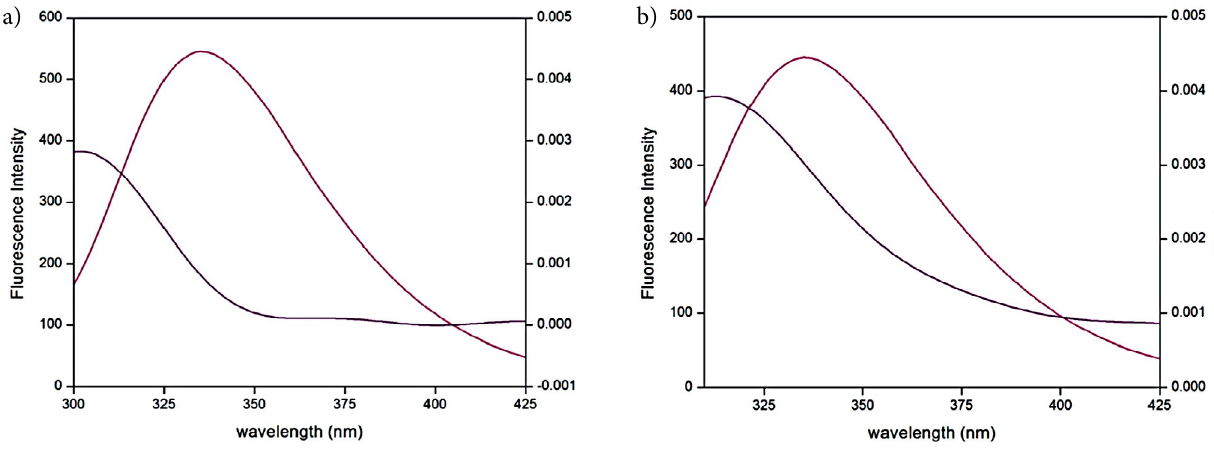
Fig 9: Spectral overlap of UV-Vis absorption spectrum of metal complexes with the fluorescence emission spectrum of BSA. c (BSA) = c (Metal com- plex) = 2 × 10 –6 mol L –1 , T = 298 K (a) Spectral overlap of MnL (b) Spectral overlap of